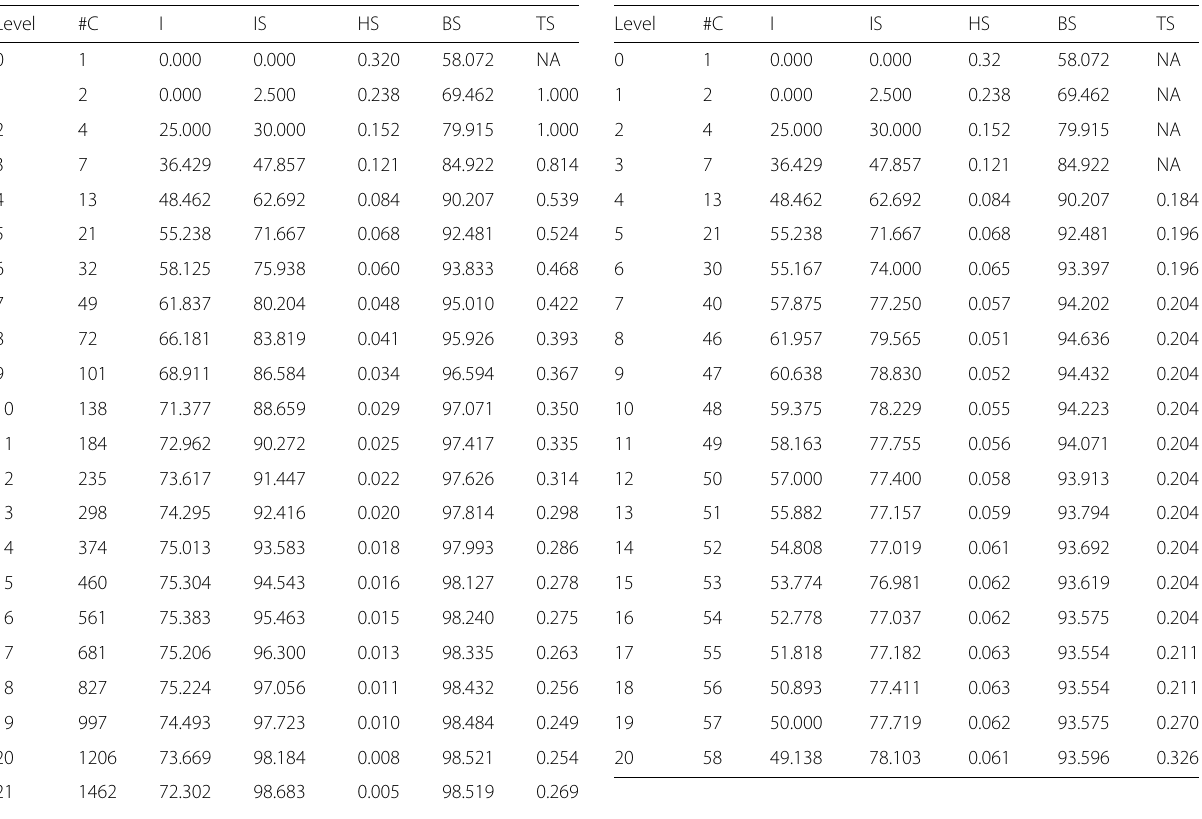
Table 7 Average values of the internal clustering